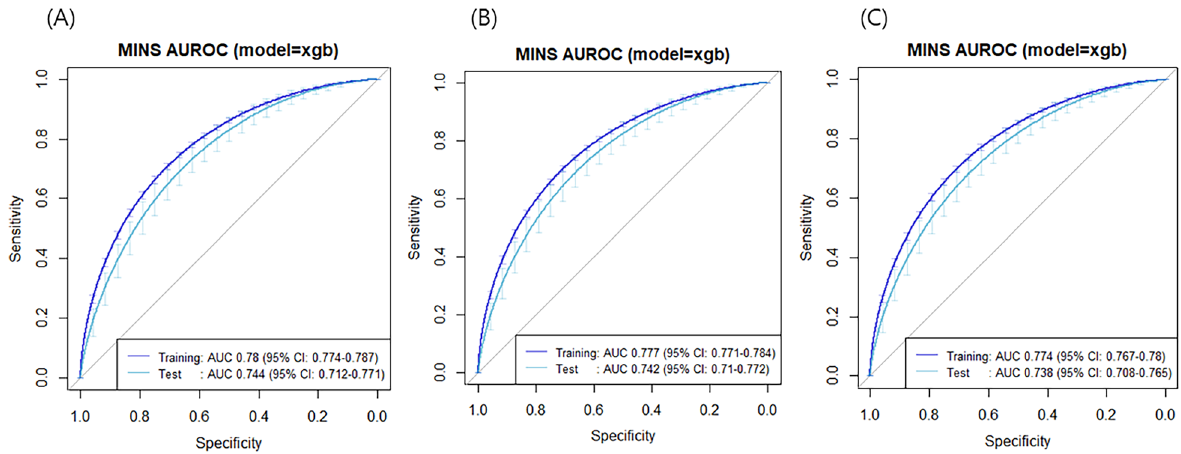
Figure 3. The receiver operating characteristic curves of the ( A ) 52-variable model, ( B ) 12-variable model, and ( C ) 6-variable